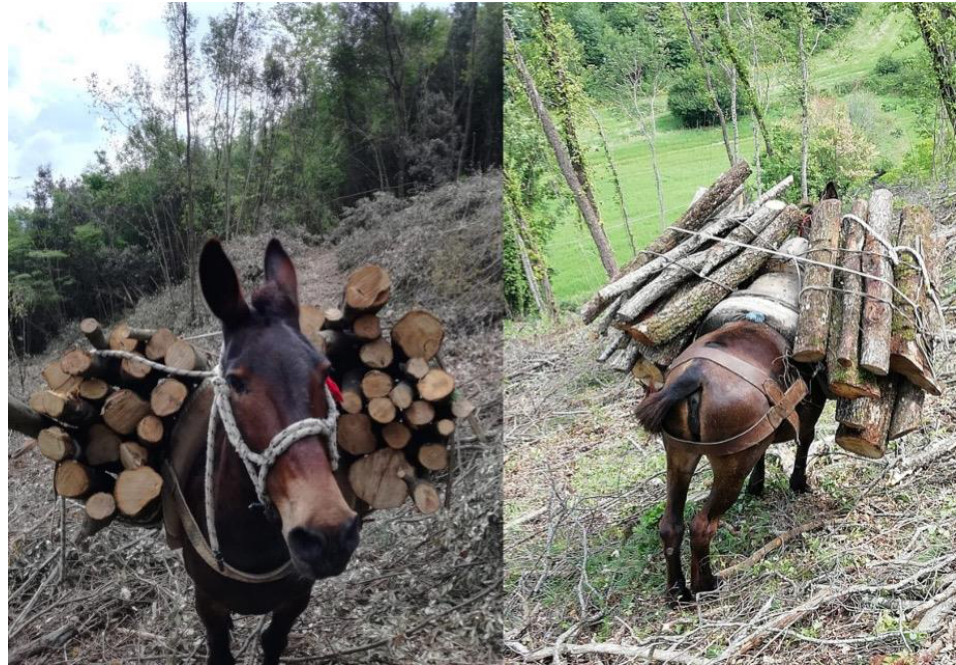
Figure 1. Working mules carrying wood. The use of an appropriate harness can easily avoid the occurrence of skin lesions due to wood weight.